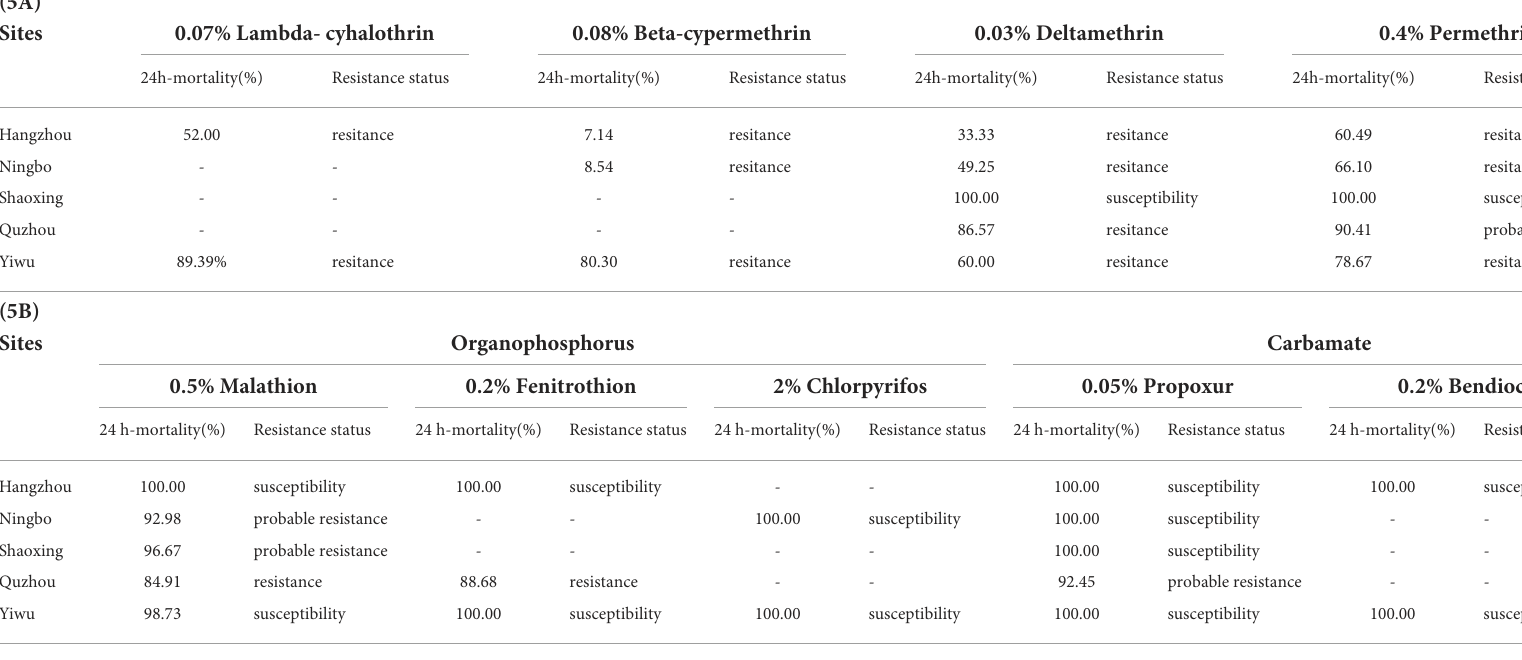
TABLE 5 Insecticide resistance of Aedes albopictus against pyrethroids, organophosphorus, and